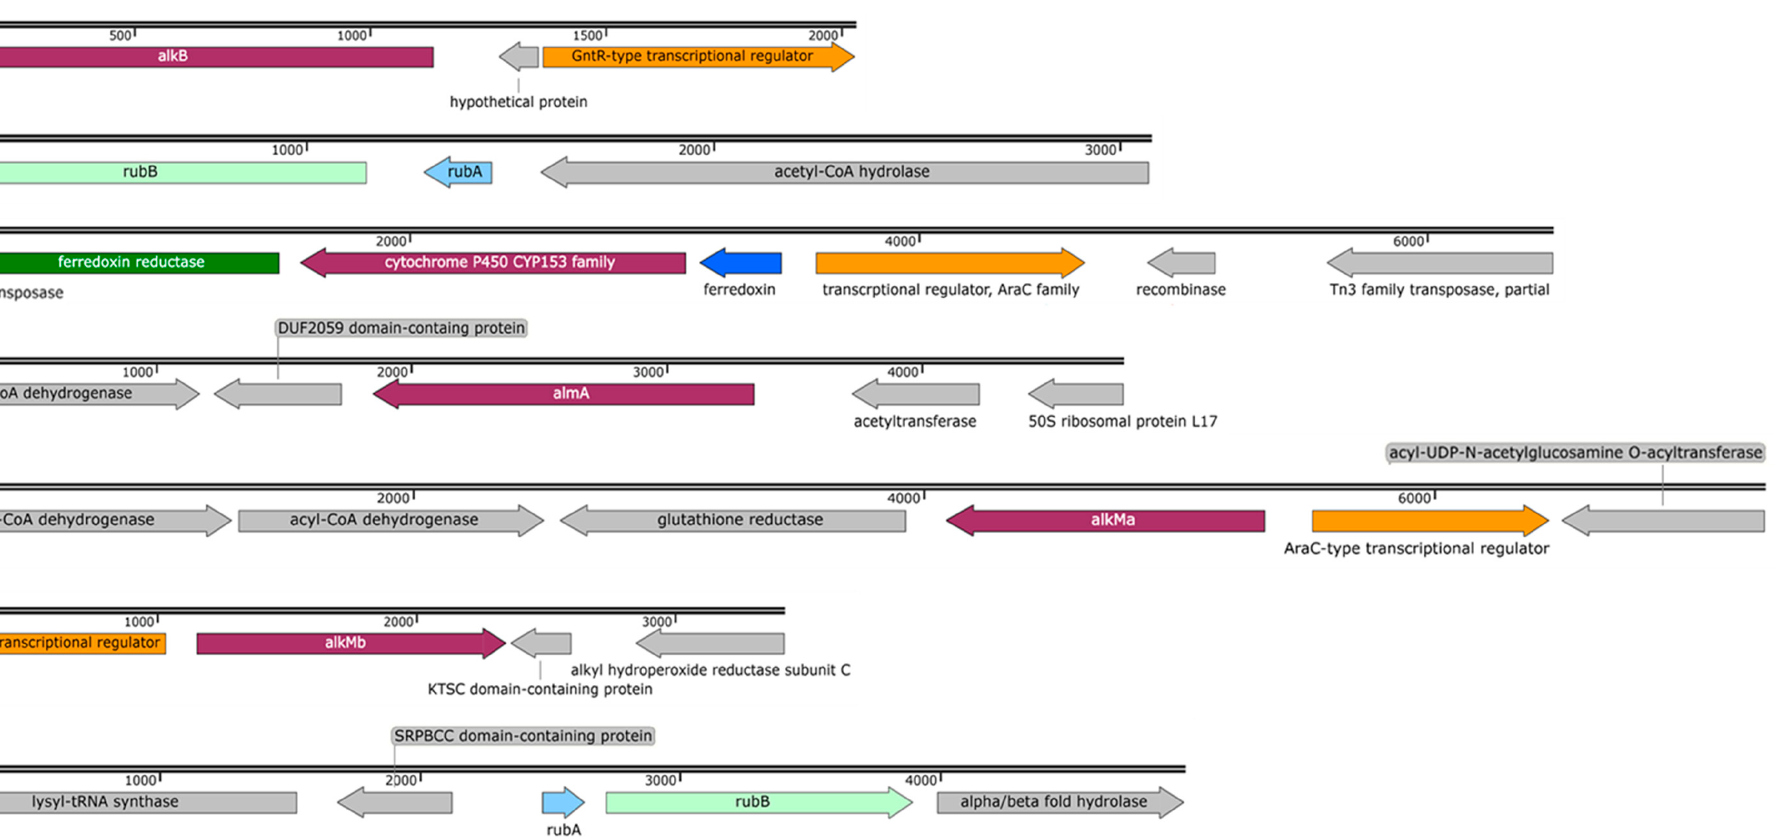
Figure 6. Schematic profile of the genomic organization of the alkane hydroxylases and genes related to alkane degradation in P. oleovorans strain ICTN13 [( A ) alkB (OK245472) and ( B ) rubAB (OK245473)] and in A. venetianus strain ICP1 [( C ) P450 (OK143499), ( D ) almA (OK181059), ( E ) alkMa (OK181057), ( F ) alkMb (OK181058), and ( G ) rubAB (OK245471)].